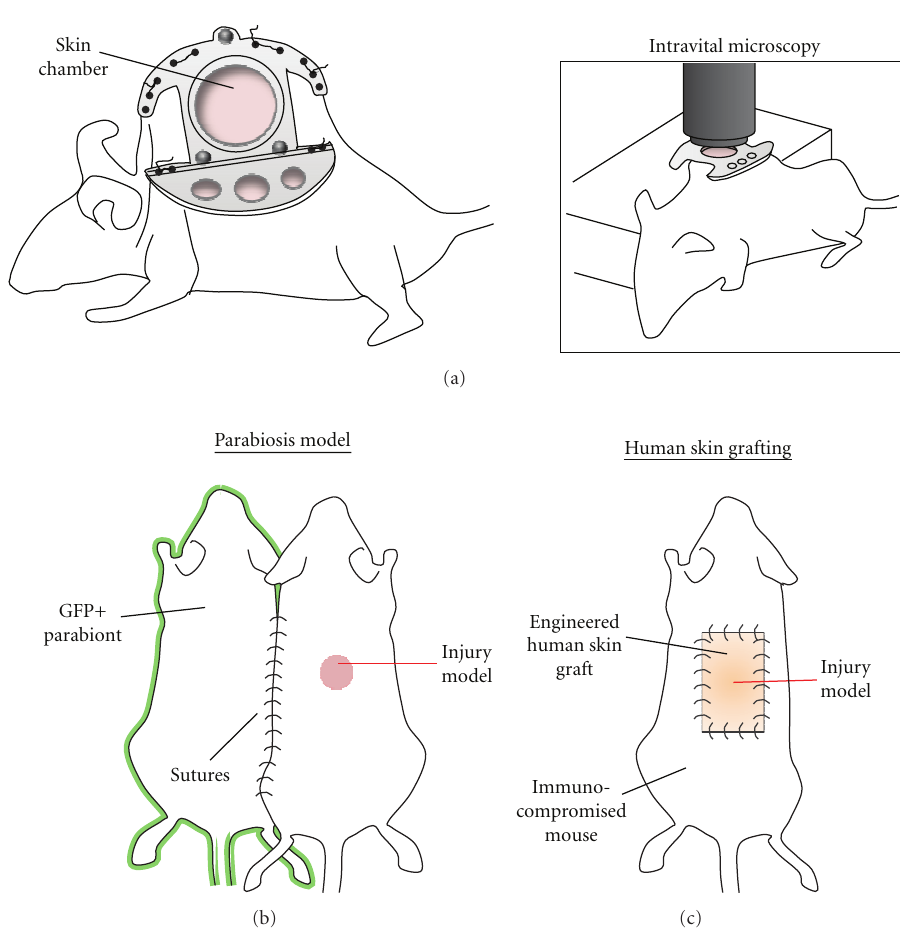
Figure 2: Schematic of commonly employed surgical mouse models of human disease. (a) The dorsal skin fold chamber allows real- time imaging of cutaneous physiology in high resolution when combined with intravital microscopy techniques (right). (b) Parabiotic models permit researchers to investigate the role of circulating factors and/or cells from the donor parabiont in cutaneous wound repair. (c) Engineered human skin constructs can be grafted onto immunocompromised mice to study human skin explant physiology within a living biologic (immunodeficient)